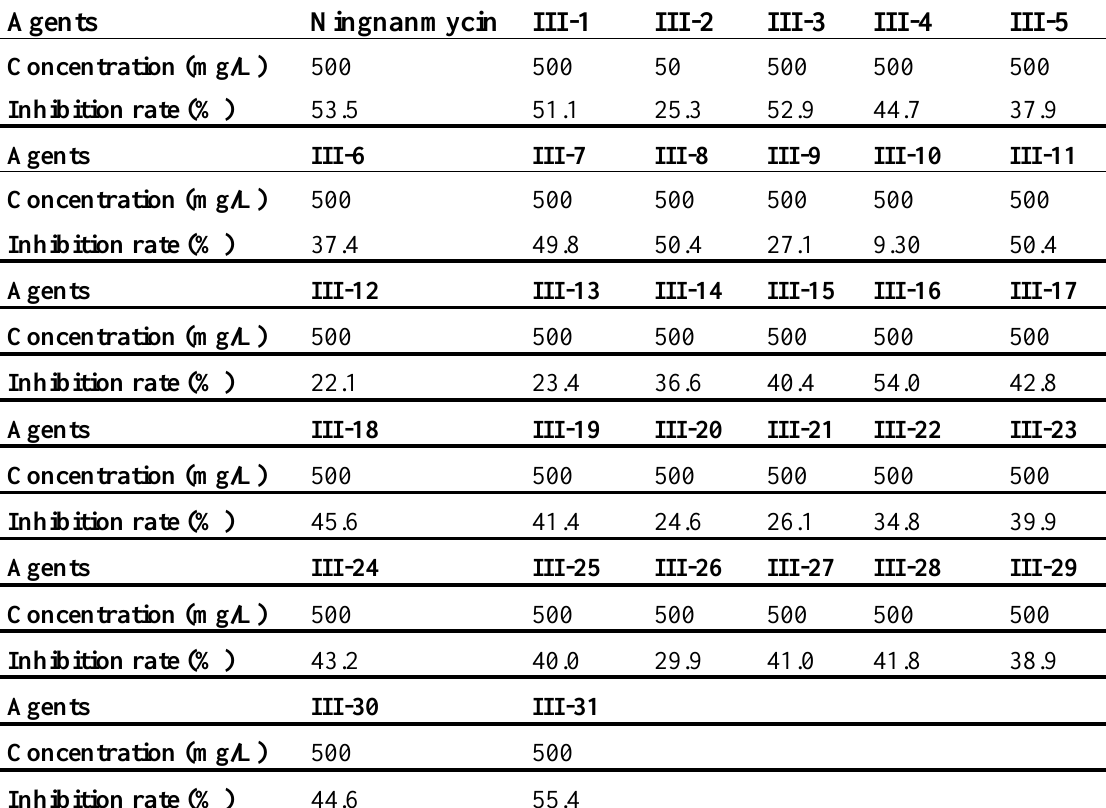
Table 6. The curative effects of the new compounds III against TMV in